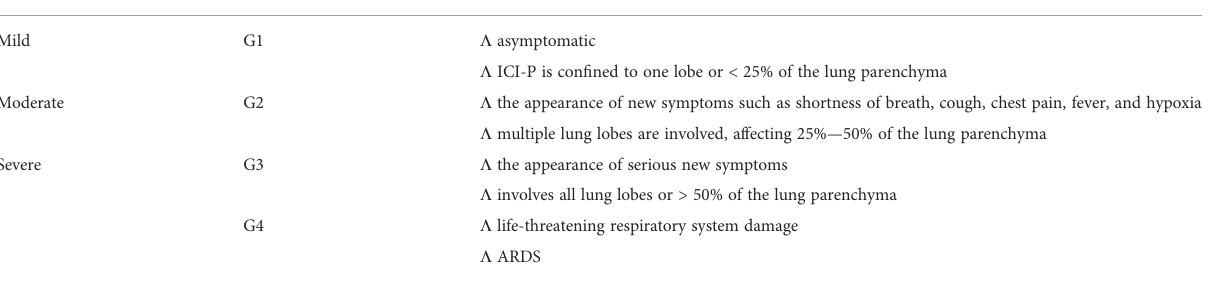
TABLE 4 Grading of immune checkpoint inhibitor-related pneumonitis. Level Grade Description